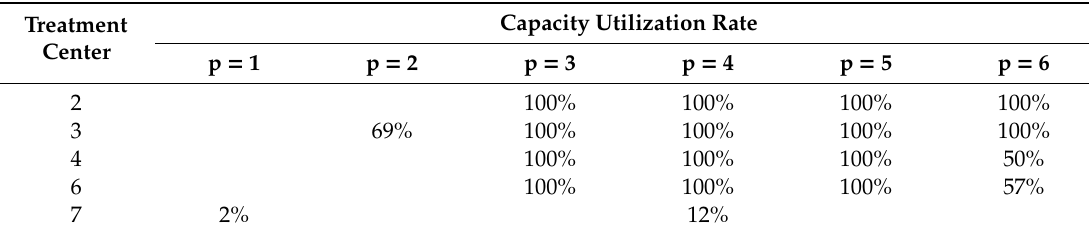
Table 9. Facility utilization rate in each